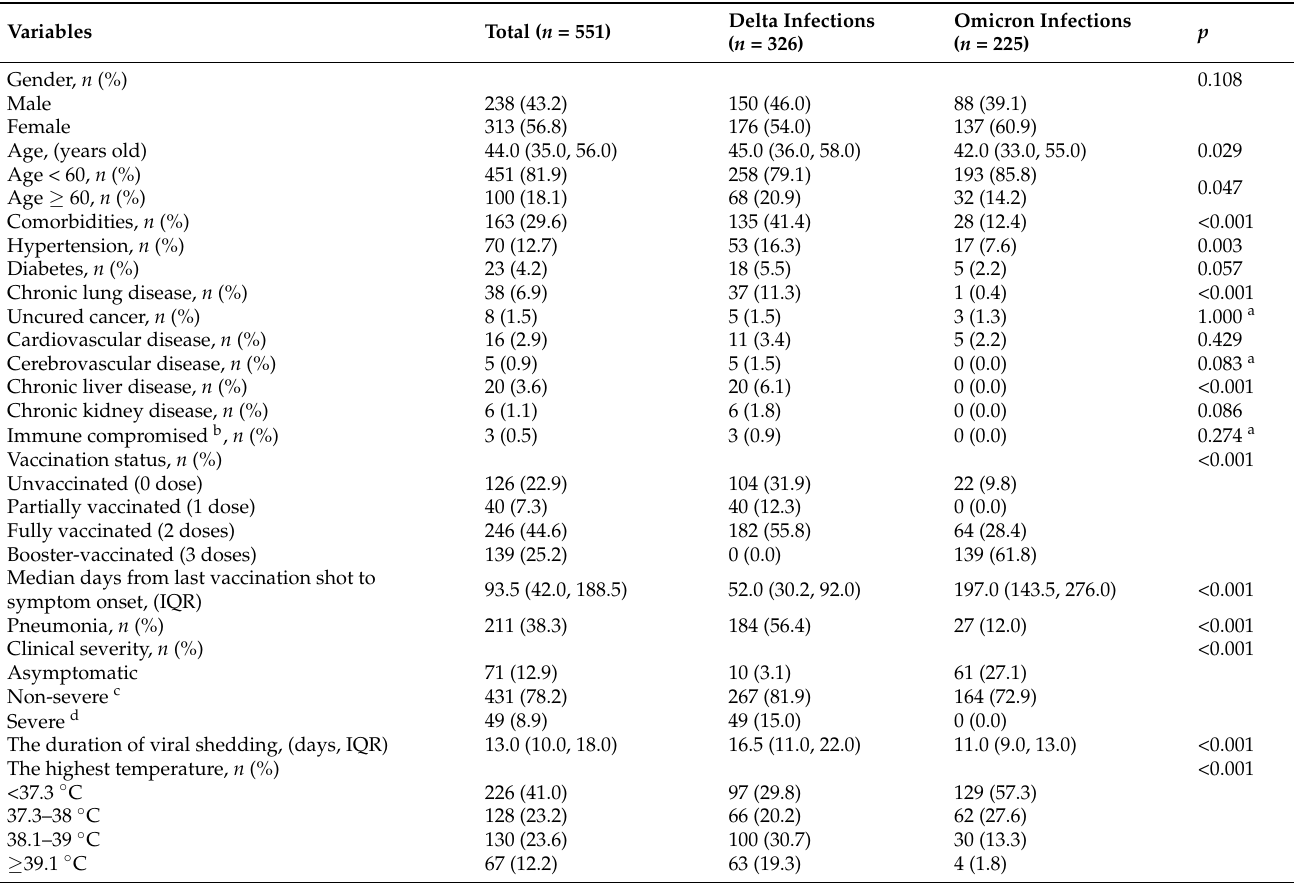
Table 1. Demographic and clinical characteristics of cases infected with Delta and Omicron